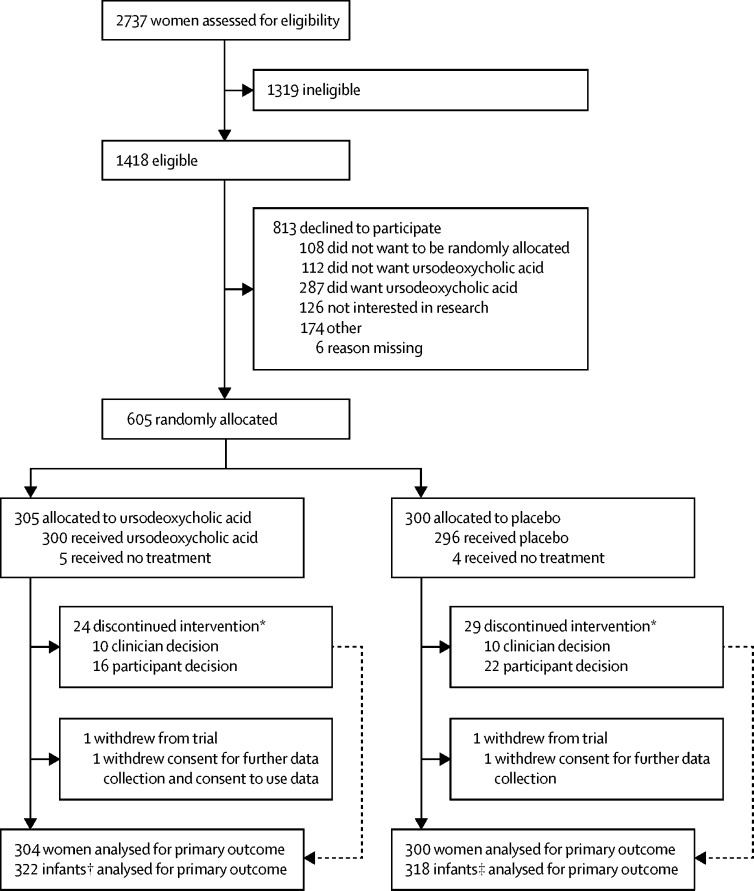
Trial profile*Reasons are not mutually exclusive. †322 of 323 infants born to women allocated to ursodeoxycholic acid; one infant was excluded because the mother withdrew consent for use of data and further data collection. ‡318 of 319 infants born to women allocated to placebo; one infant was excluded because the mother withdrew consent for further data collection.